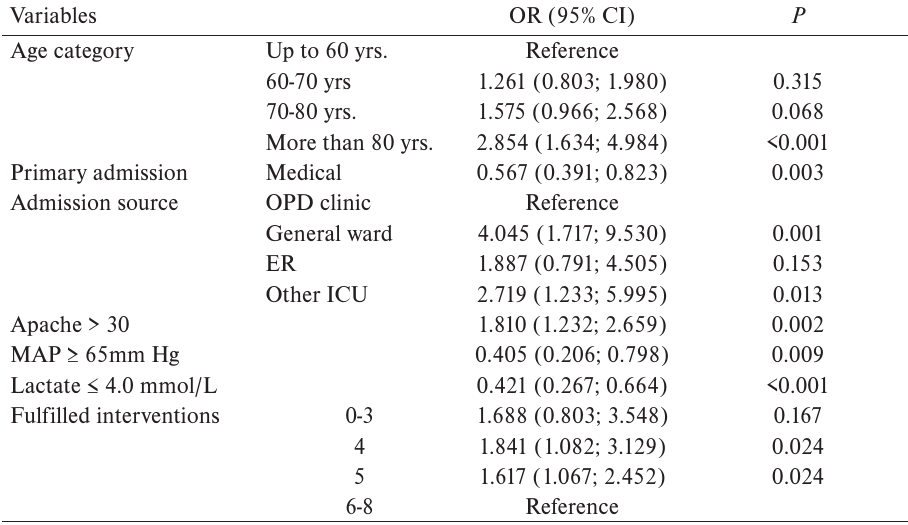
Table 8. Multivariate analysis of factors associated with in-hospital